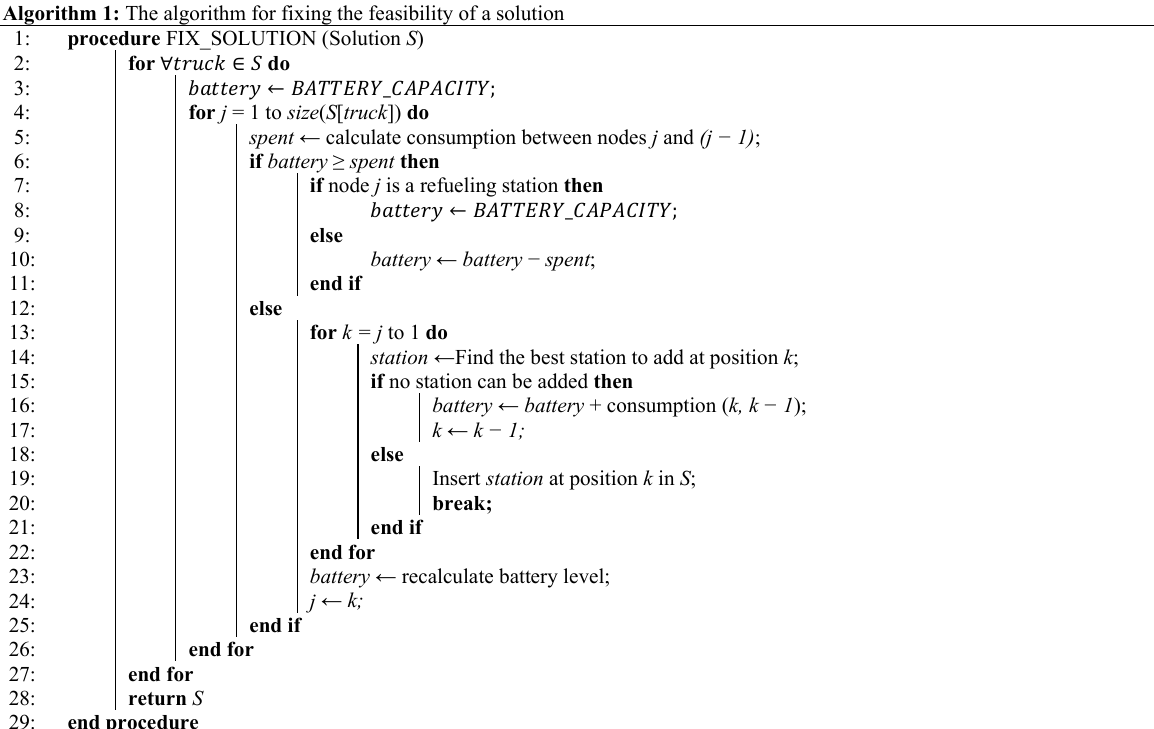
Algorithm 1: The algorithm for fixing the feasibility of a